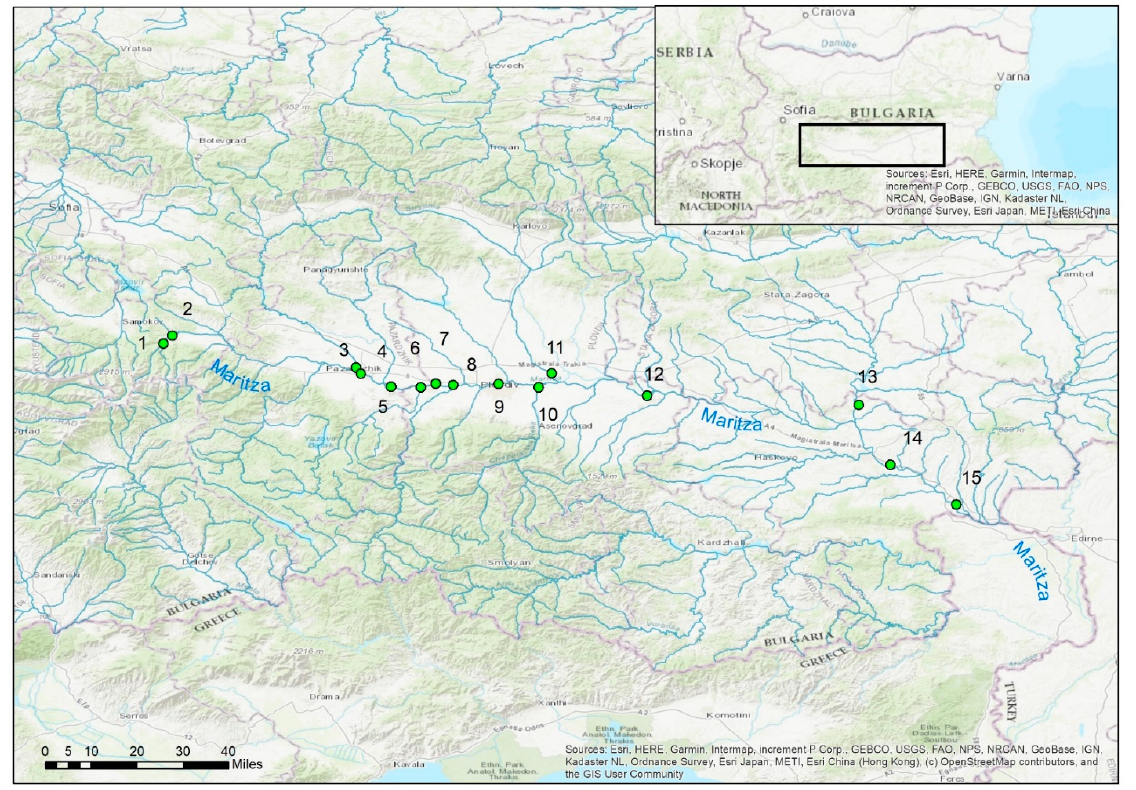
Figure 1. Location of the studied sites along the Maritsa River.